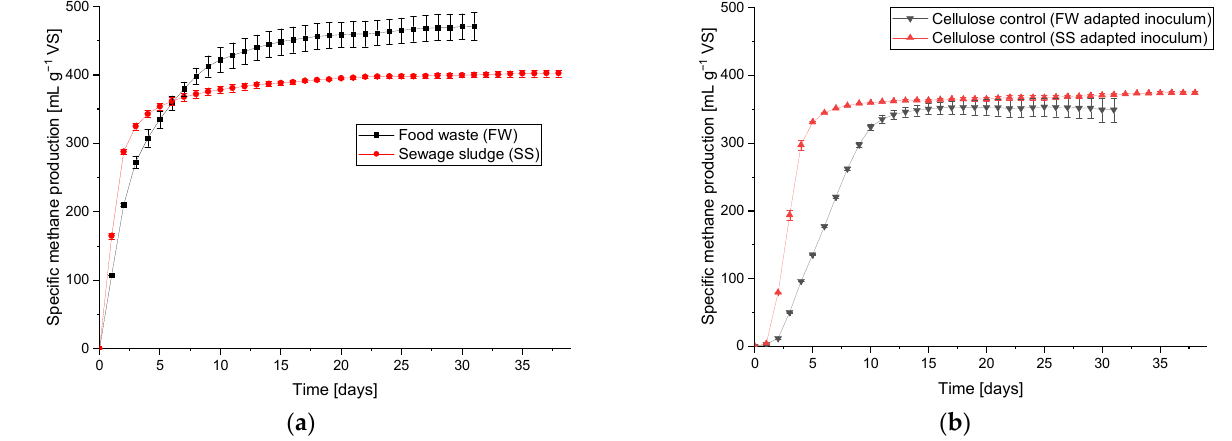
Figure 4. BMP test profiles for FW and SS ( a ), and the cellulose control for both inoculums ( b ) .